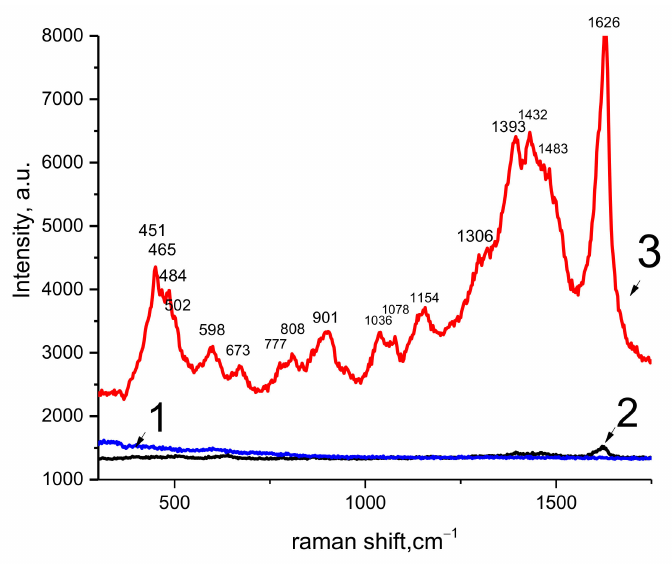
Figure 9. Raman spectra of the MB film deposited on I (1), II (2), III (3)